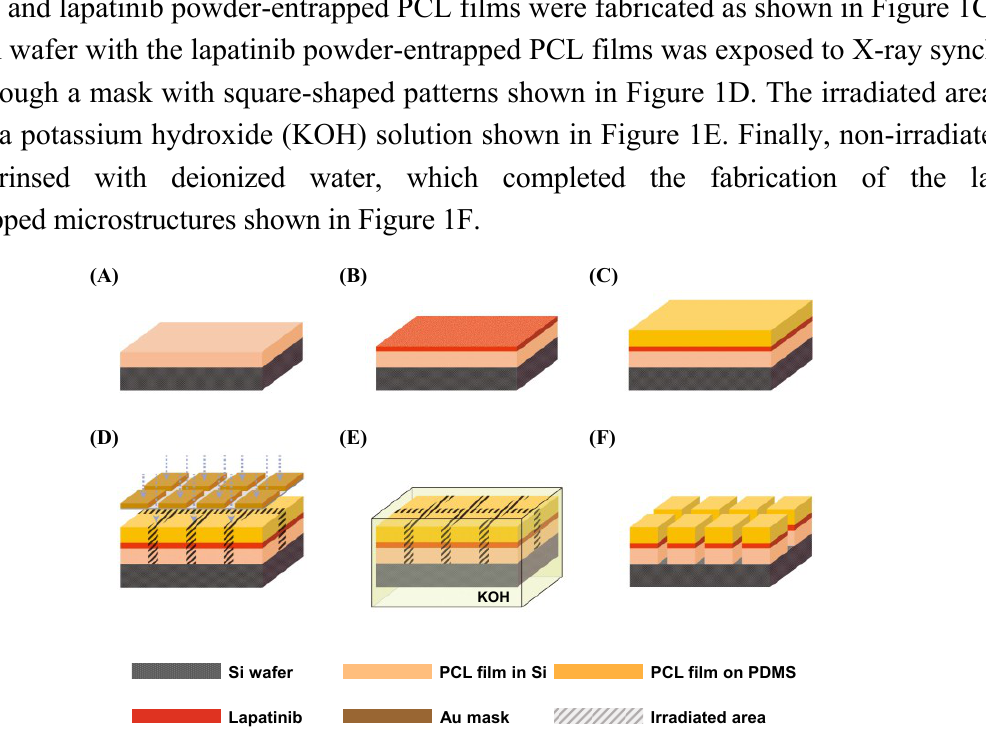
Figure 1. Illustration of X-ray lithography-based microfabrication methods. ( A ) A PCL film was spin-coated on a Si wafer; ( B ) Lapatinib powder was spread onto the PCL film; ( C ) Lapatinib powder was entrapped between two laminated PCL films with a lamination process; ( D ) Lapatinib powder-entrapped PCL films were exposed to X-ray